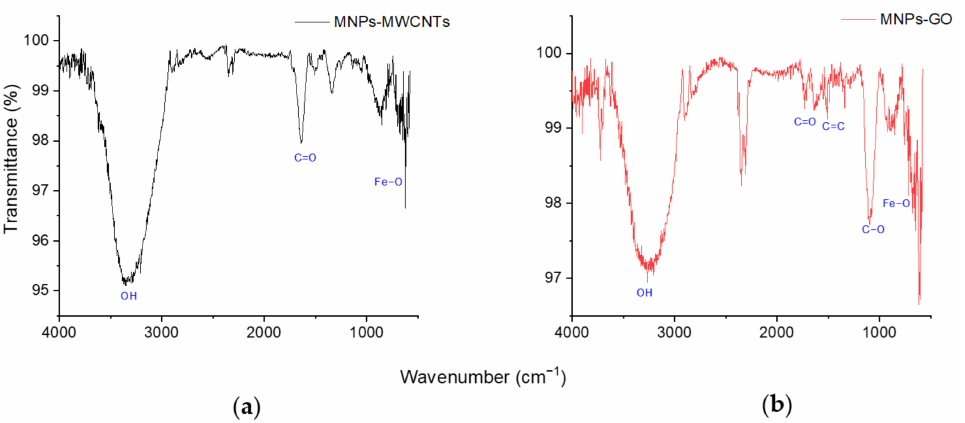
Figure 1. FT-IR spectra: ( a ) MNPs-MWCNTs; ( b )